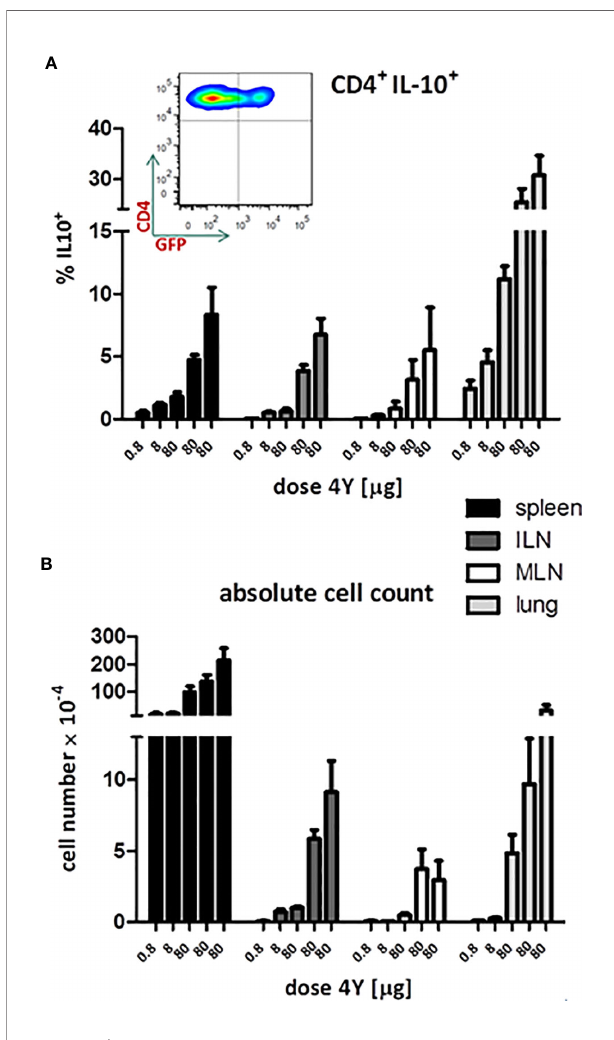
FIGURE 5 | IL-10 production in tiger-Tg4 mice during dose escalation immunotherapy. Tg4GFP/IL10 mice were treated with 4Y according to the dose escalation protocol in Figure 3E . Different organs were isolated from 6 mice over 2 independent experiments (ILN=inguinal lymph nodes; MLN=mediastinal LN). The inset shows a representative cytometry plot from a spleen after the last dose of 4Y gated on live single CD4+ T cells. Bar graphs show mean ± SEM. (A) represents % of GFP + cells among gated CD4 + cells whereas (B) shows the absolute number of GFP + IL-10 producing CD4 +